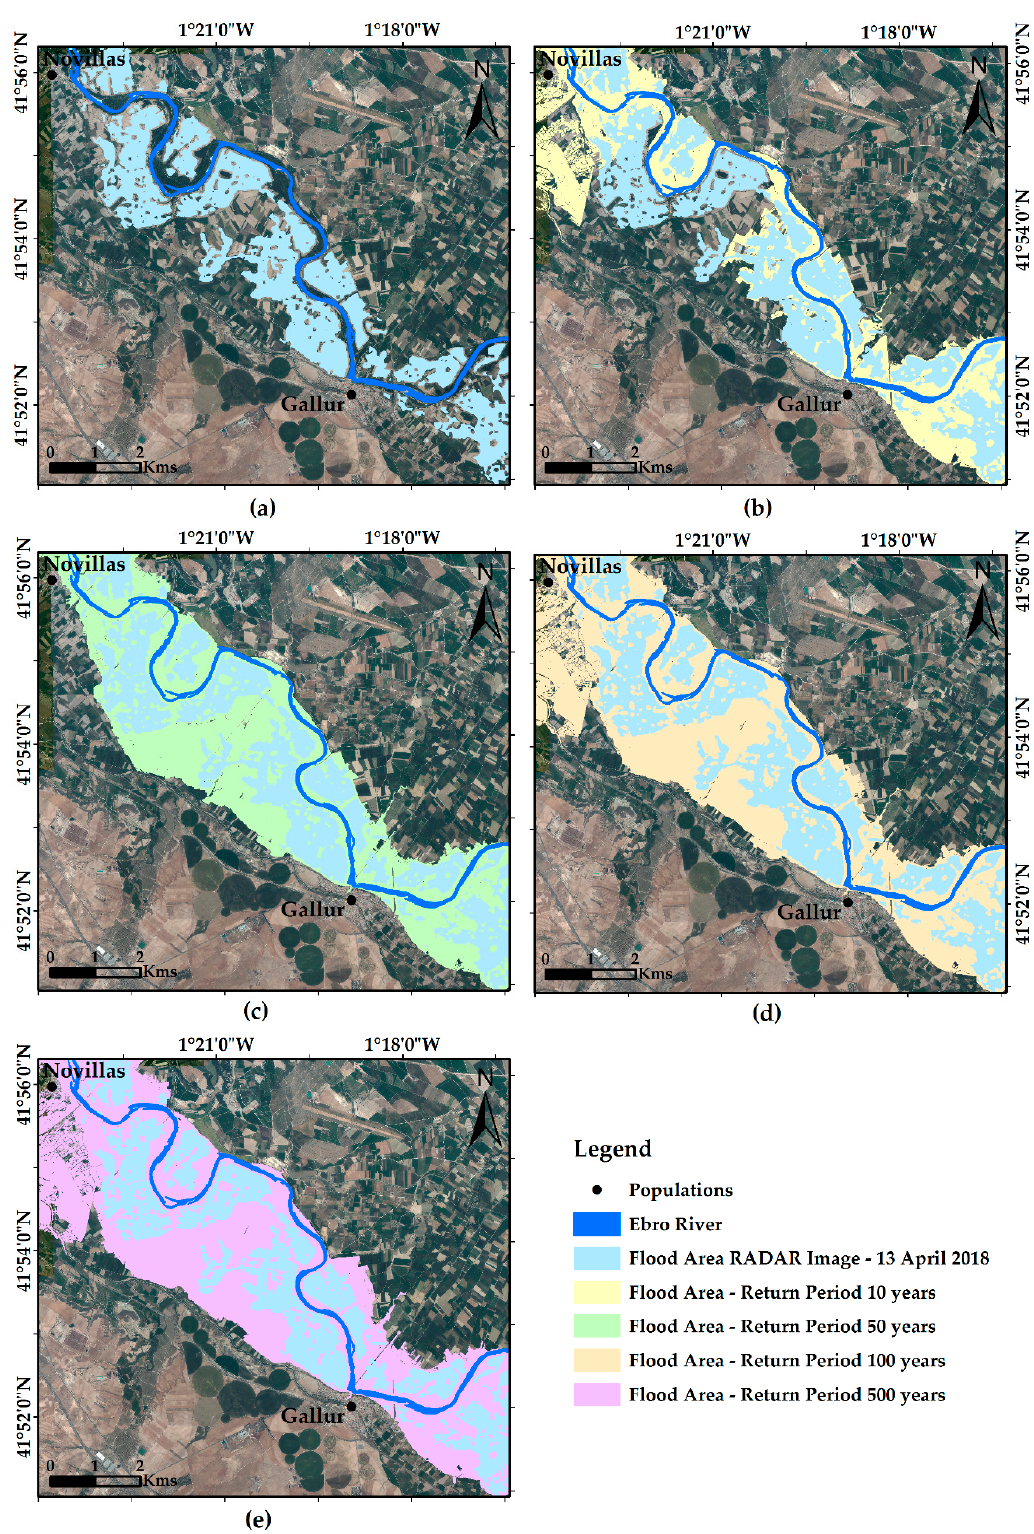
Figure 16. Comparative maps between ( a ) flood area RADAR image (13 April 2018) and ( b ) flood area high probability (10-year return period), ( c ) frequent flood zone (50-year return period), ( d ) flood zone of medium or occasional probability (100-year return period), and ( e ) flood zone of low or exceptional probability (500-year return period) (Source: MITECO, 2017, [66]).